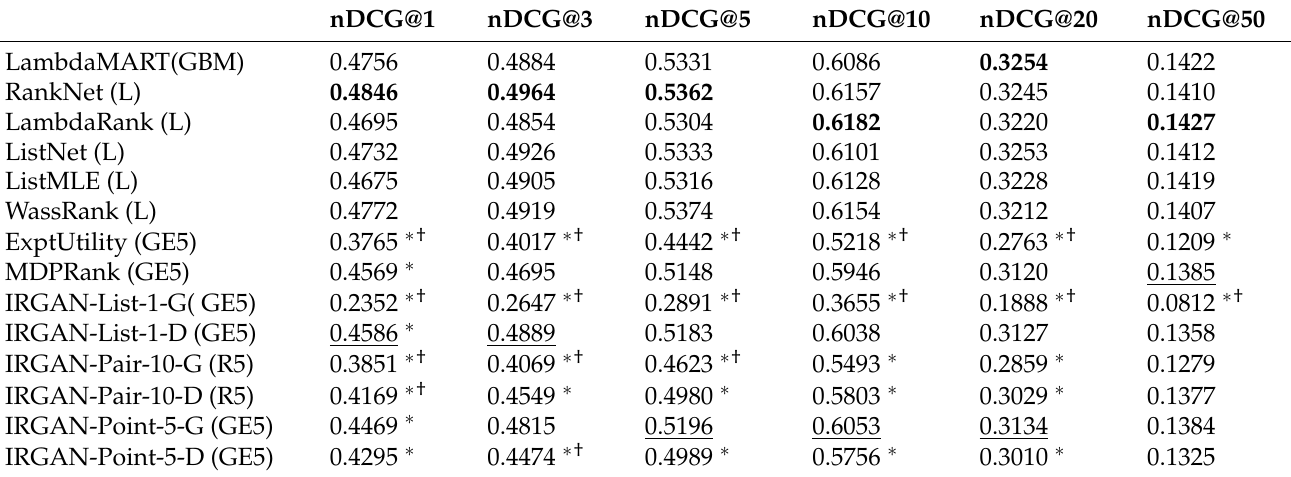
Table 4. The performance of involved approaches in